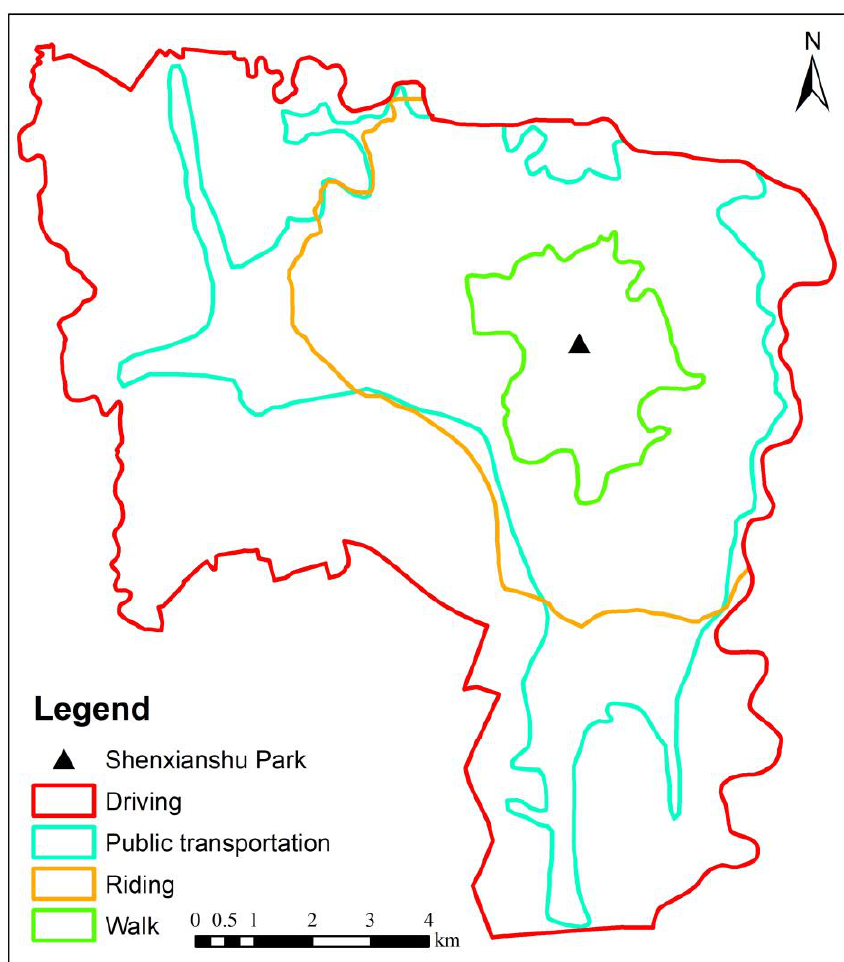
Figure 4. The search